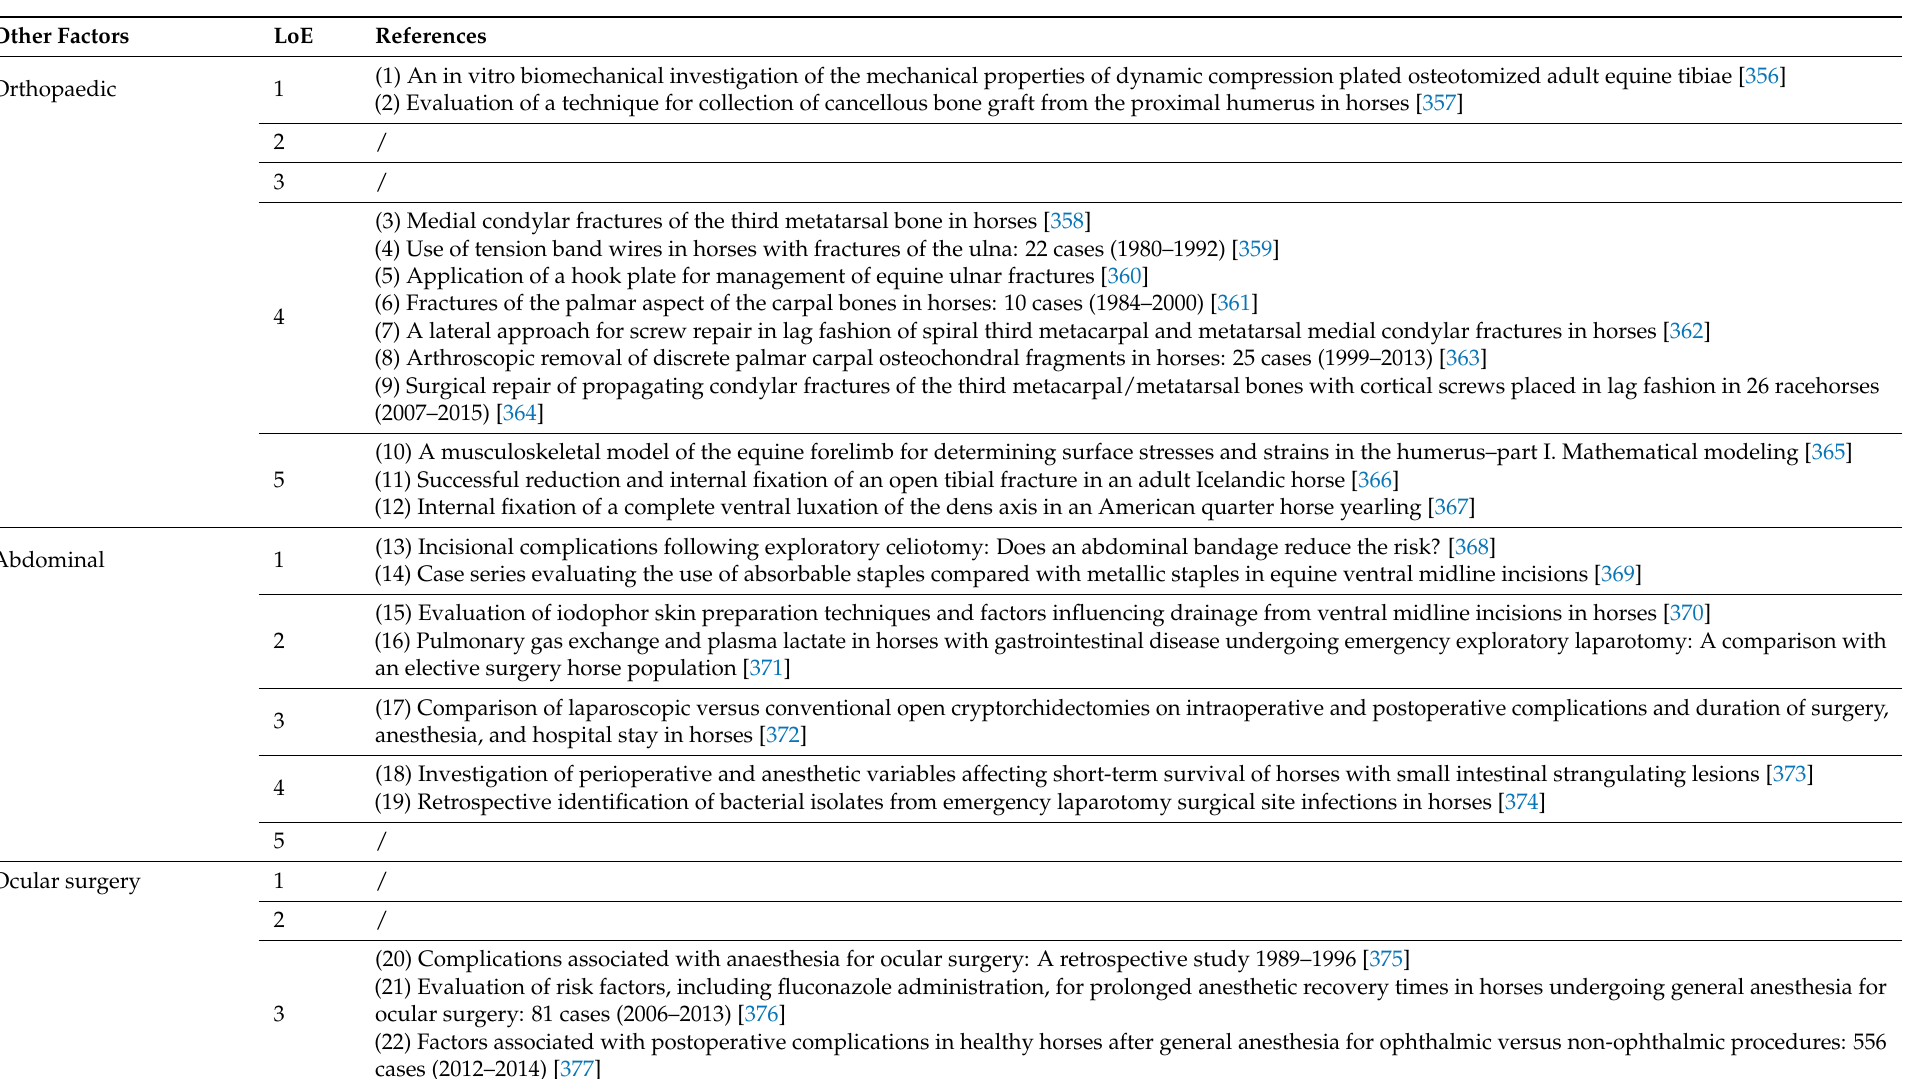
Table 11. Total of publications giving information about the effects of “ other factors ” on the recovery